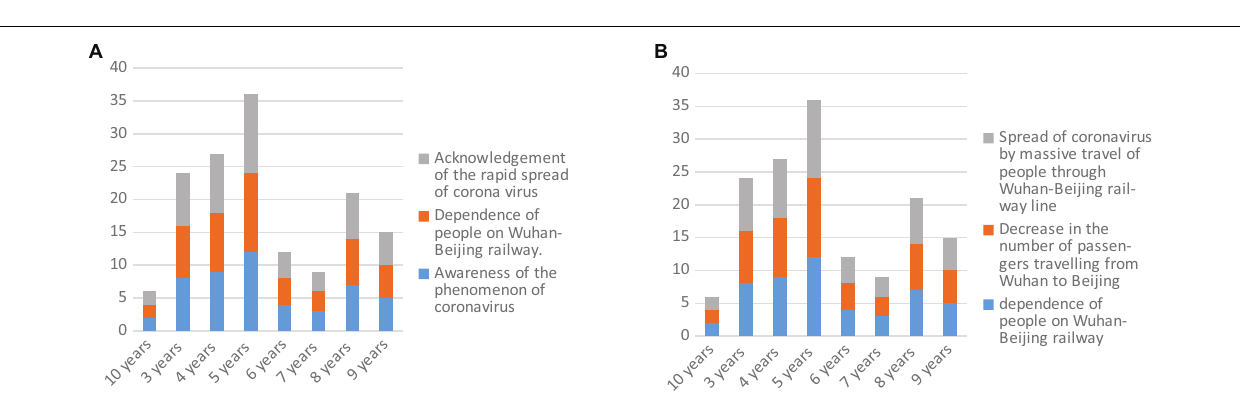
Wuhan significantly depend on rail transport, which is why railway transport heavily contributes to the spread of the disease. Given the increasing number of cases and consequent deaths, the flow of railway passengers has been reduced to a notable